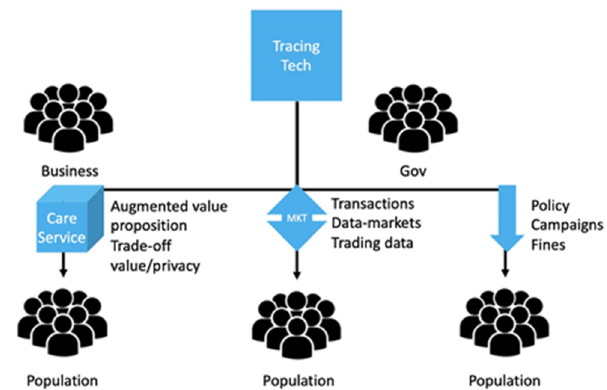
Figure 12. Adoption Approaches.